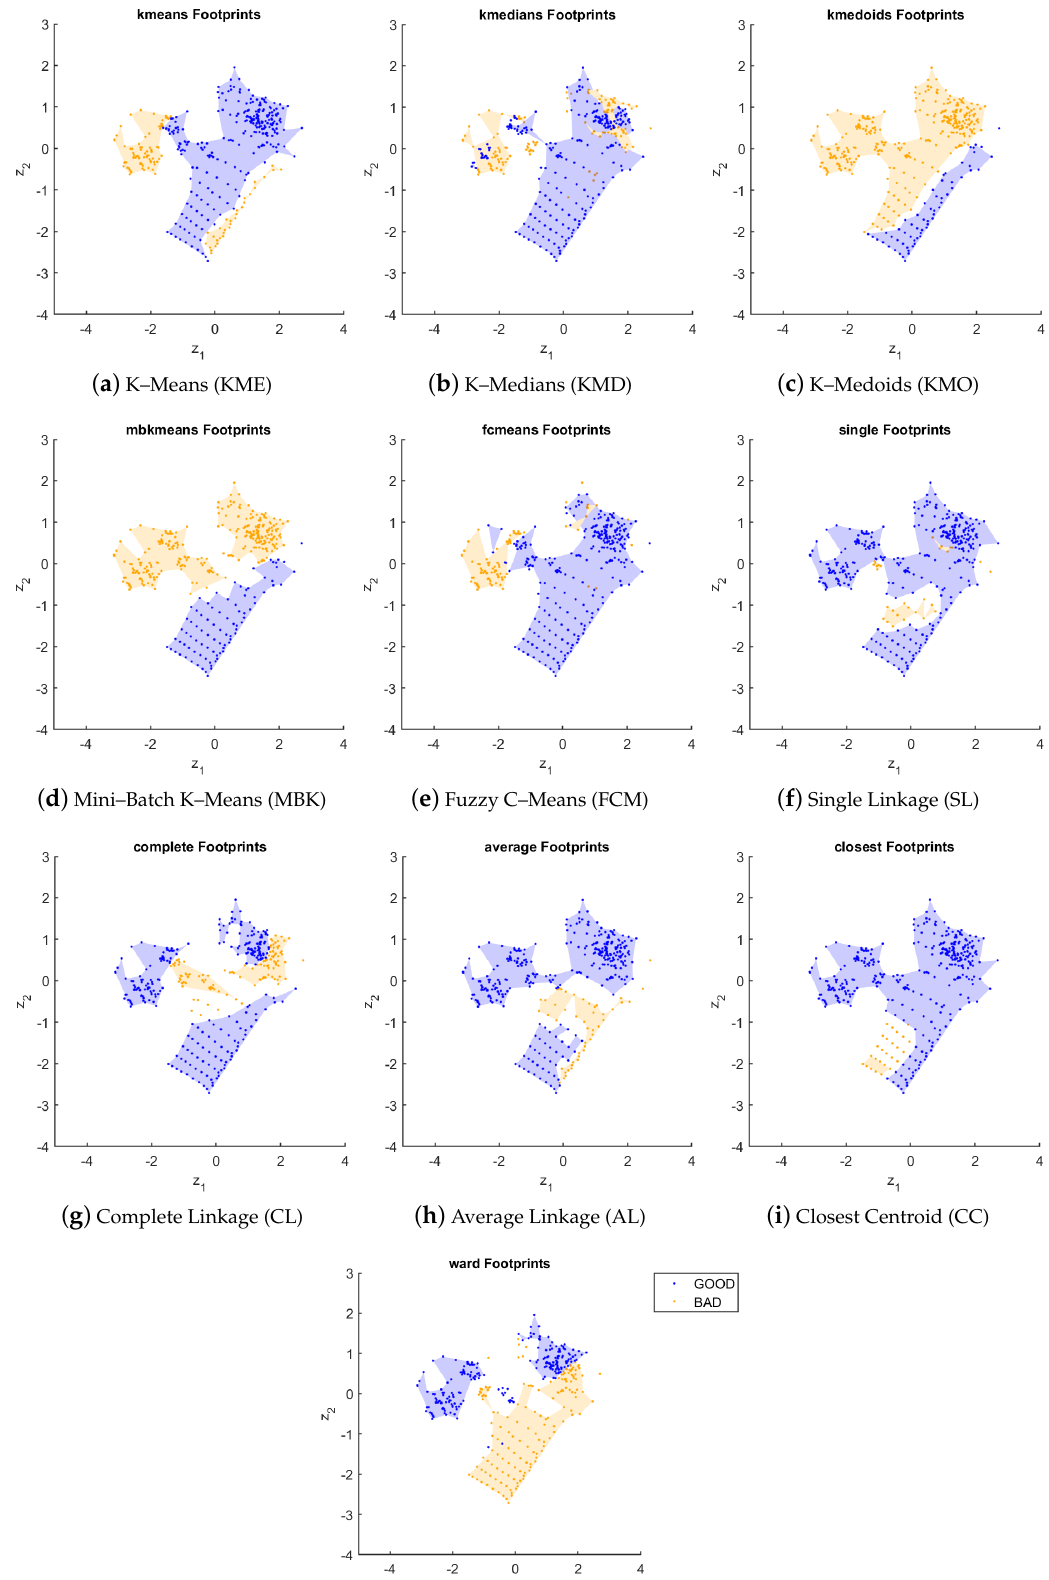
Figure 6. Footprints of the algorithms in the instance